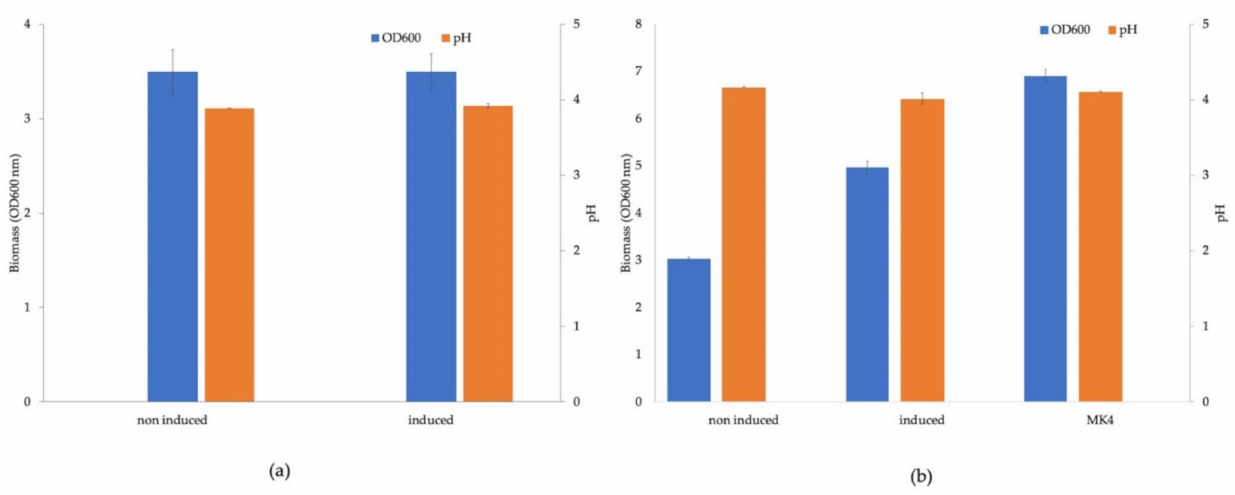
Figure 5. Cultivation of Lactipl. plantarum carrying the plasmids pSIP_lpMK_1 ( a ) and pSIP_lpMK_2 ( b ). The engineered strain was grown aerobically for 24 h at 37 ◦ C in MRS medium with IP (induced) and without IP (non-induced) as the inducer. The blue bars represent the biomass formation (OD 600 ), and the orange bars represent the final